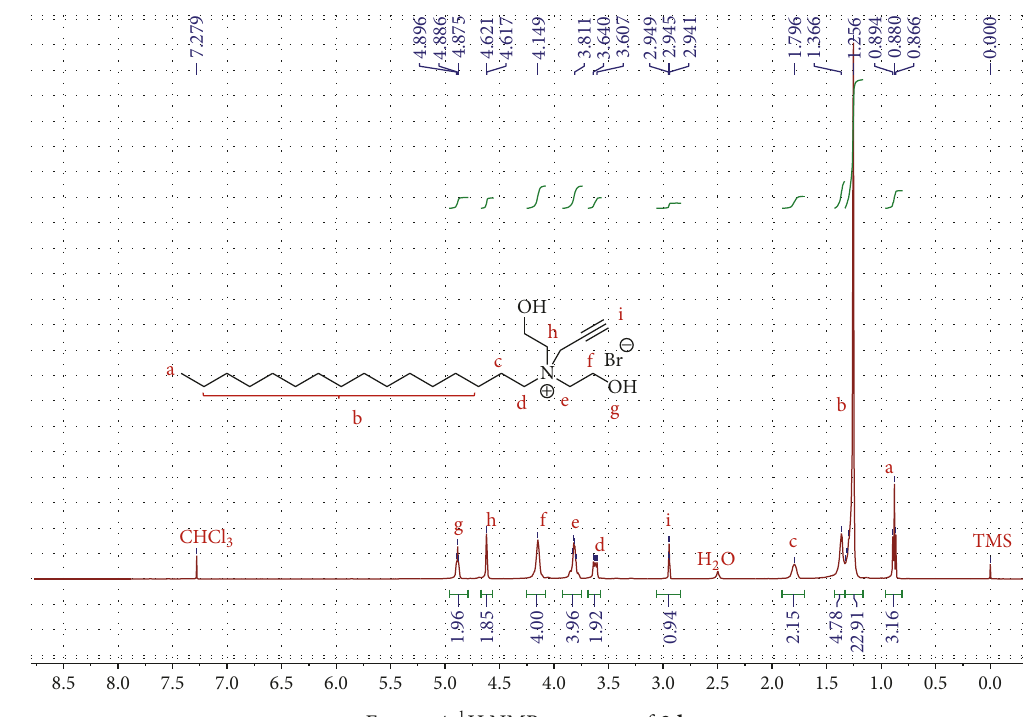
Figure 4: 1 H NMR spectrum of 2d .